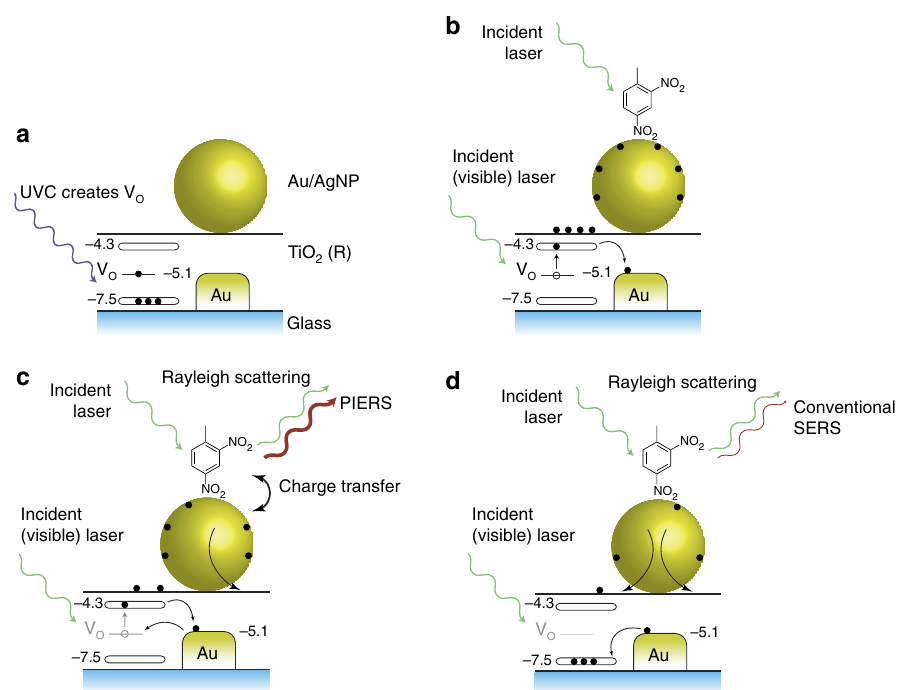
Figure 2 | Photo-induced enhanced Raman spectroscopy (PIERS). ( a ) Ultraviolet C light (UVC) pre-irradiation creates oxygen vaccencies (V O ) in the TiO 2 below the conduction band. ( b ) The sample (here dinitrotoluene) is deposited and irradiation with the Raman laser (633nm) photoexcites the TiO 2 , leading to increase in charge on the nanoparicles. ( c ) The charged nanoparticless lead to the PIERS enhancement. As the V O are replenished, upon exposure to air, fewer electrons can be photoexcited into the conduction band of TiO 2 . ( d ) The PIERS effect gradually disappears as the V O are completely replenished over time (30–60min). The substrate can then be cleaned and recharged through exposure to more UVC